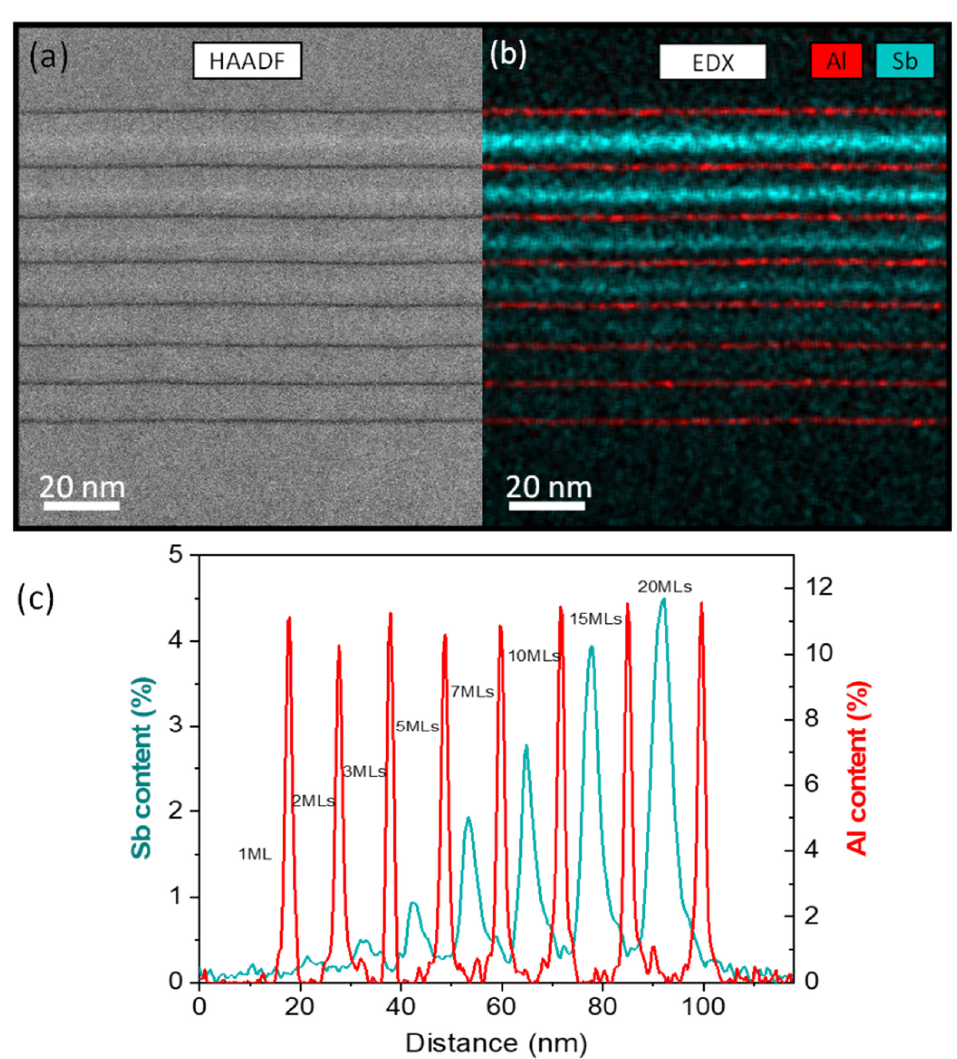
Figure 2. ( a ) Global view of the sample using HAADF imaging conditions. AlAs markers appear as darker stripes while the GaAsSb layers are brighter than GaAs. ( b ) EDX multi-channel mapping showing the Al (red) and Sb (cyan) distribution. ( c ) Average compositional profiles along the growth direction from EDX